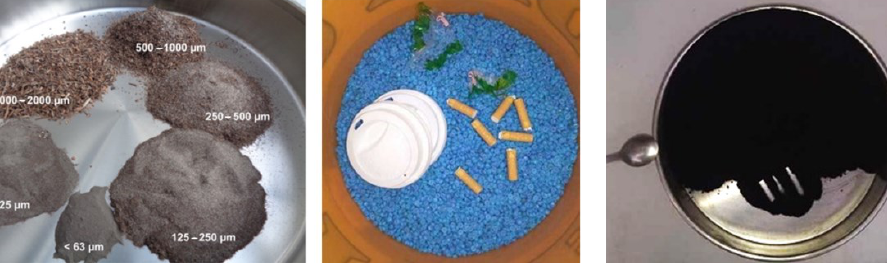
Figure 2. Test substances from left to right: real street dust, defined substances and tyre powder.